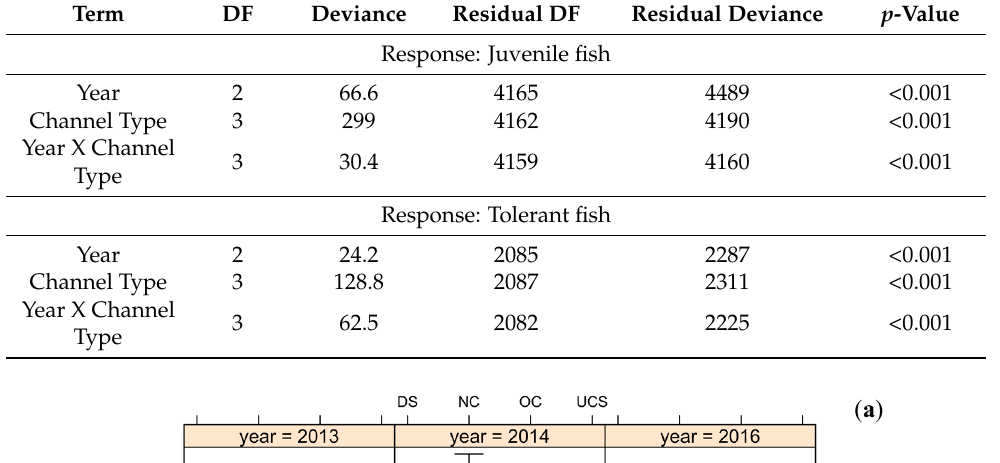
Table 3. Results of analysis of deviance from logistic regression models fitted to two responses (juvenile fish and tolerant fish) across years and channel types. DF is degrees of freedom.